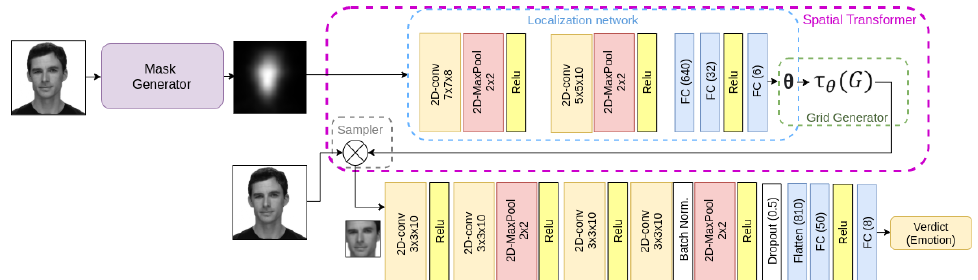
Figure 3. Spatial Transformer CNN architecture with visual saliency-based